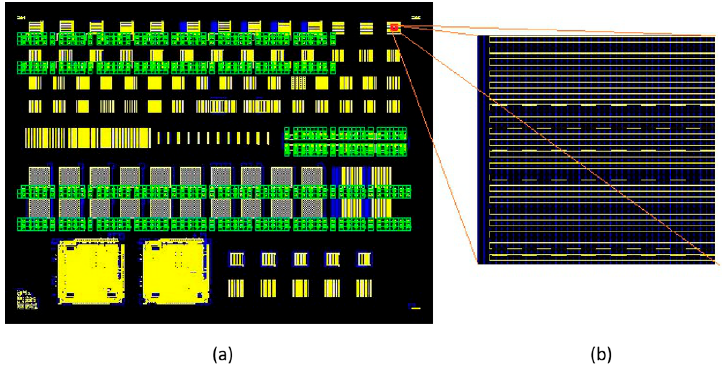
Figure 3. A test chip ( a ) and an example of a single input image ( b ).